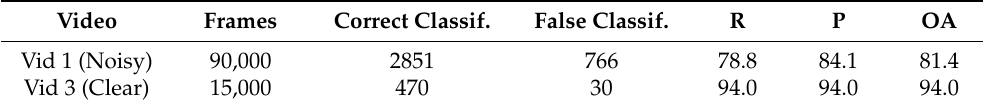
Table 7. Results of classification using YOLOv5l in terms of the quality of the video. Video Frames Correct Classif. False